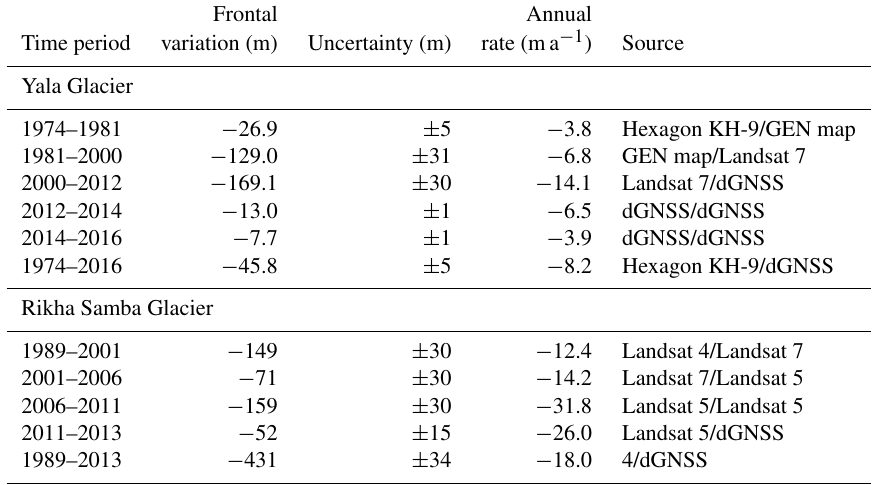
Table 4. Frontal variations of Yala and Rikha Samba glaciers.